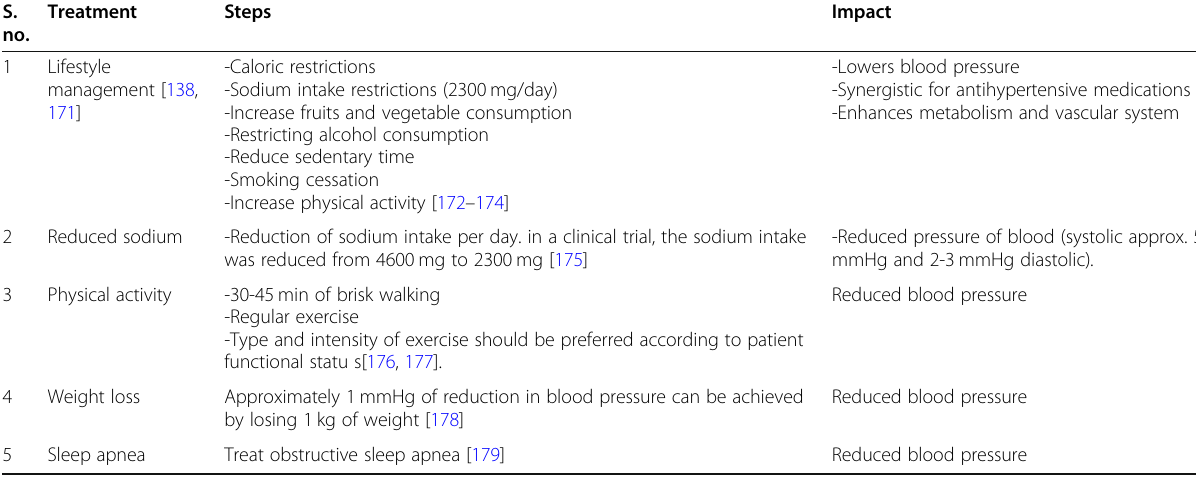
Table 8 Treatment options for hypertension associated with diabetes S. no.